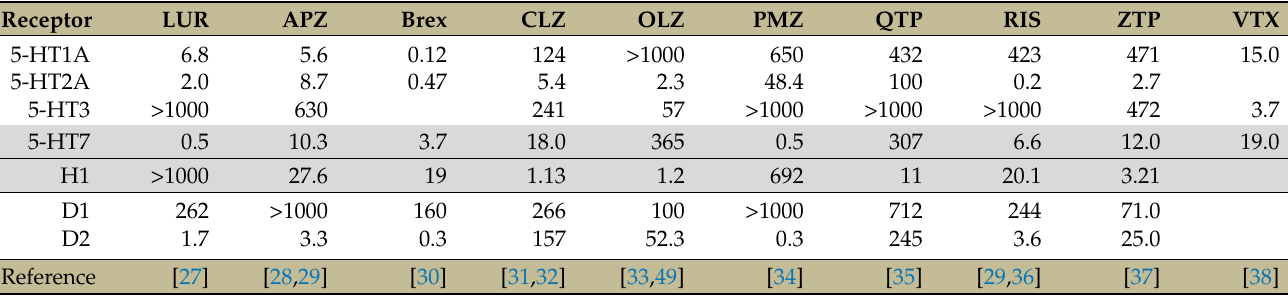
Table 1. Receptor-binding profiles of antipsychotics and